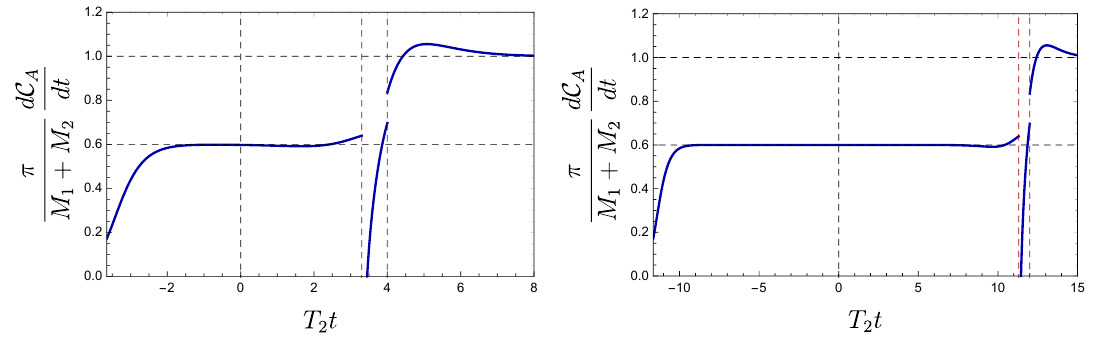
t , with T 2 t w = 2 L = t R = 2 M 1 ) =(cid:25) in eq. (3.52), (cid:0)